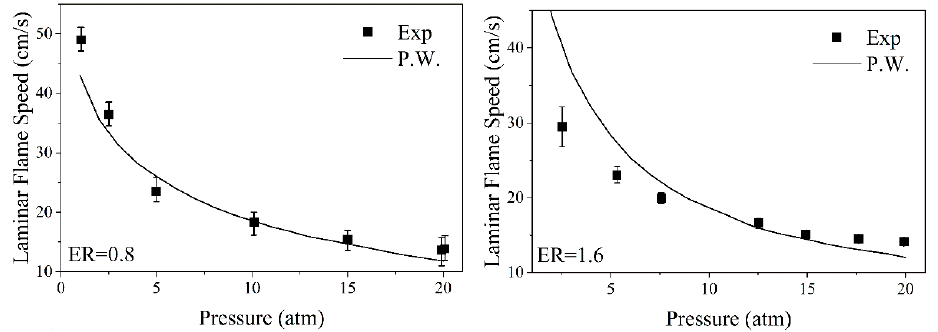
Figure 4. Influence of different pressure on laminar flame speed. P.W.—present work. Exp—experimental data [36].